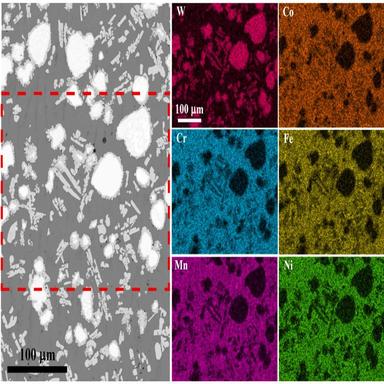
SEM image and EDS elemental maps representative of the microstructure in regions 2–4, highlighting the Fe7W6 intermetallic region that formed between the primarily W particles and CoCrFeMnNi matrix.